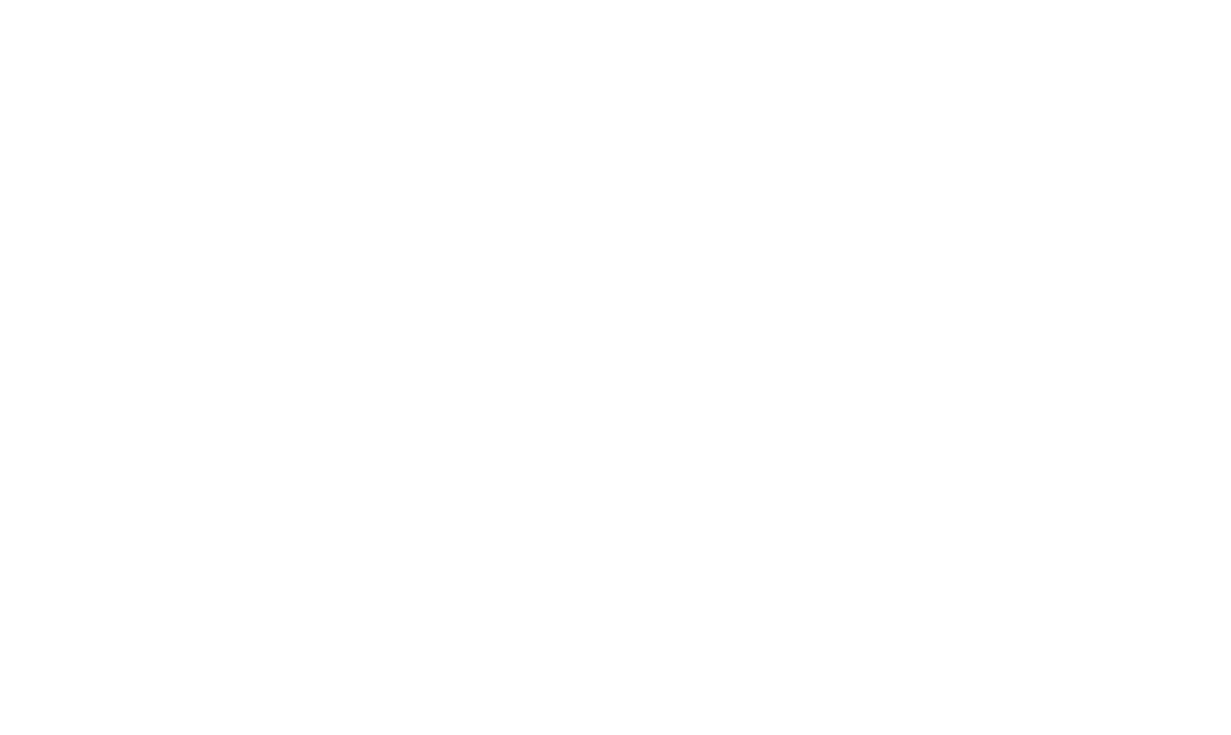
Genotyping count Allele frequency Multiplicative